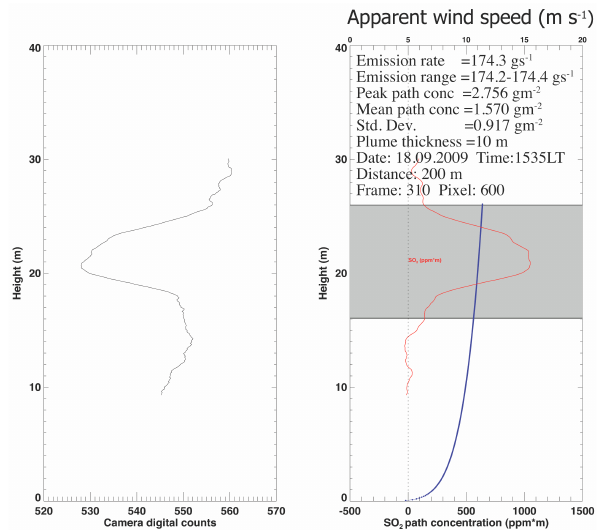
Fig. 11. SO 2 path concentration ( u , in ppmm) for NYK Cool